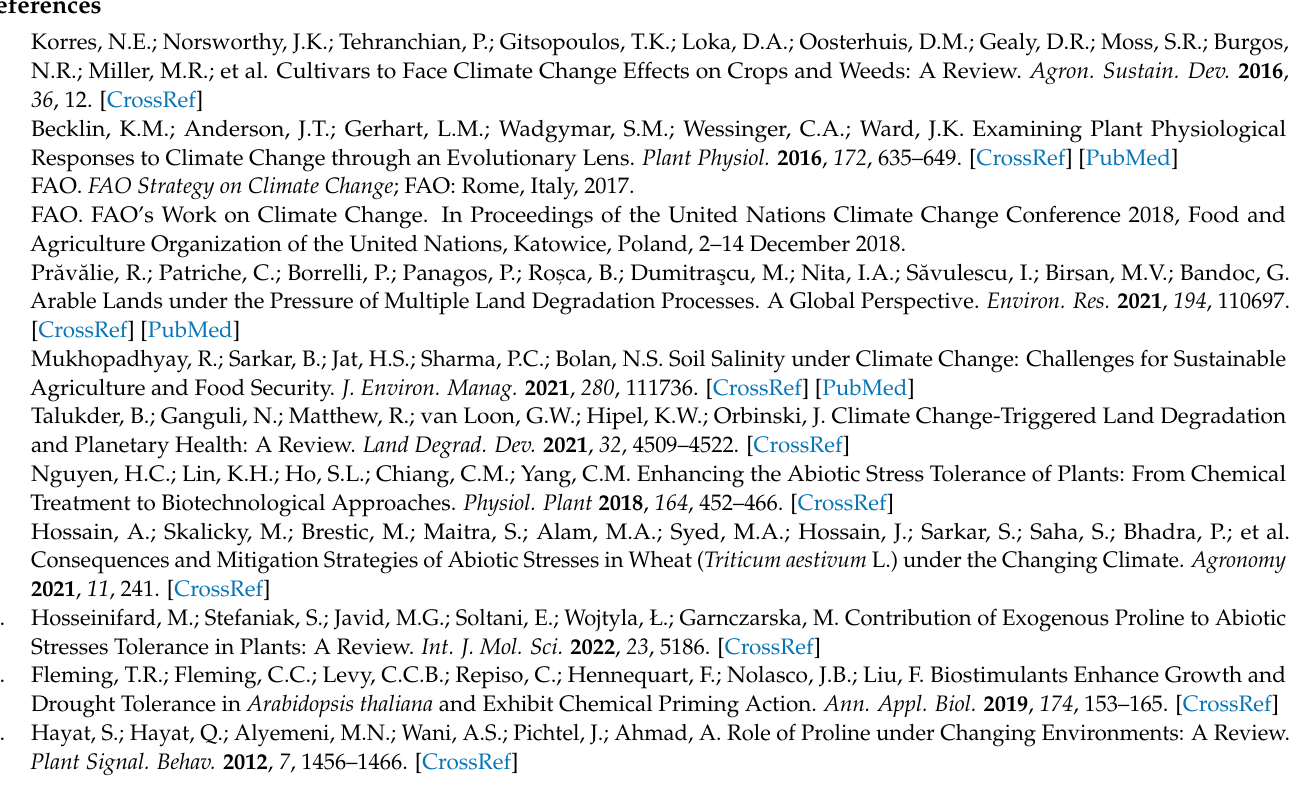
Table S3: Effects on overall plant physiology and on the proline accumulation in plants facing heavy-metal-induced stress; and Table S4: Effects of applying stress mitigators to plants facing xenobiotics-induced stress, namely on the endogenous levels of proline. References [185–218] are cited in the supplementary